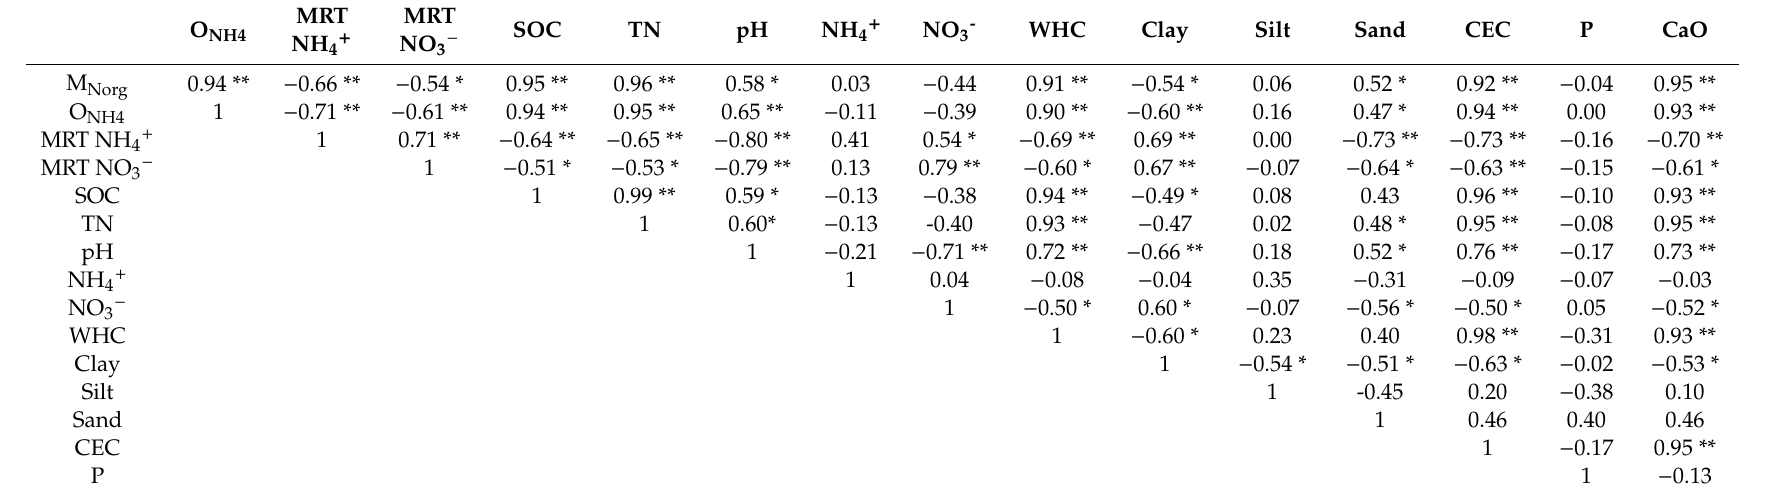
Table 2. The relationships between soil properties, M Norg and O NH4 rates, MRT NH 4 + and MRT NO 3 − (n =